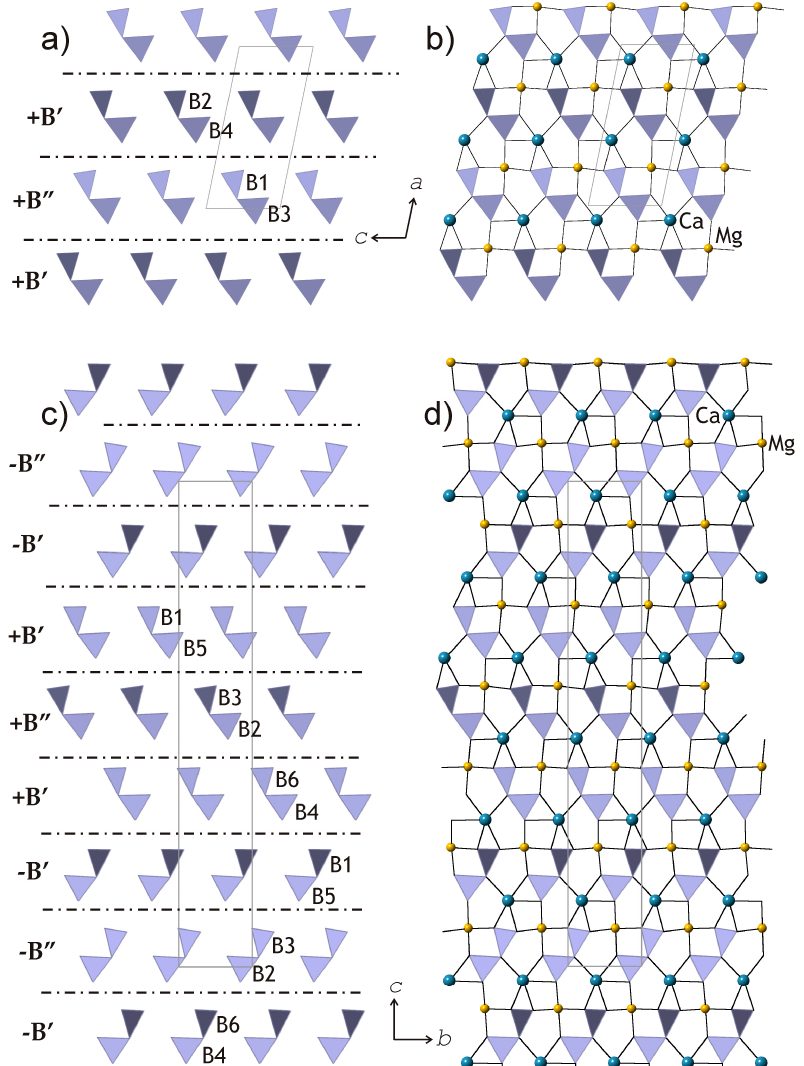
Figure 4. The slices of the crystal structures of clinokurchatovite ( a , b ) and kurchatovite ( c , d ) and consisting of diborate groups (divided along the dashed lines as shown in Figures 1 and 2). The dot-and-dash lines in ( a , c ) indicate the relative positions of the B’ and B” of different orientations (distinguished by the “ + ” and “ − ” signs).